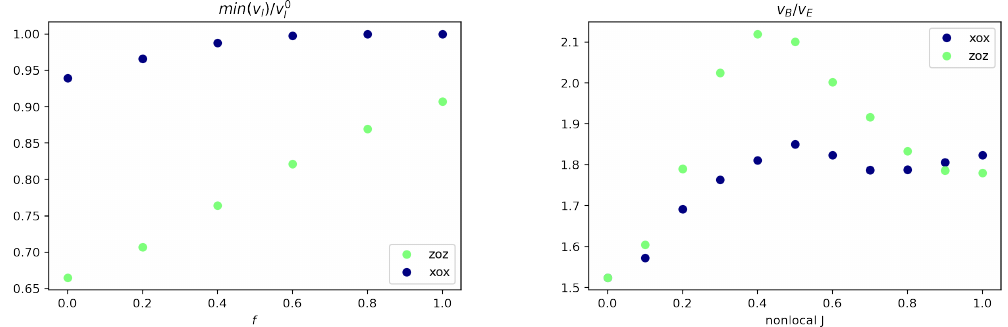
Figure 5 . Left: ratio of the minimum information velocity to the information velocity at zero nonlocal coupling ( J xox = J zoz = 0 ), denoted v 0 , as a function of entanglement fraction f . Right: I ratio of the butterfly velocity to the entanglement velocity as a function of the nonlocal coupling ( J xox or J zoz